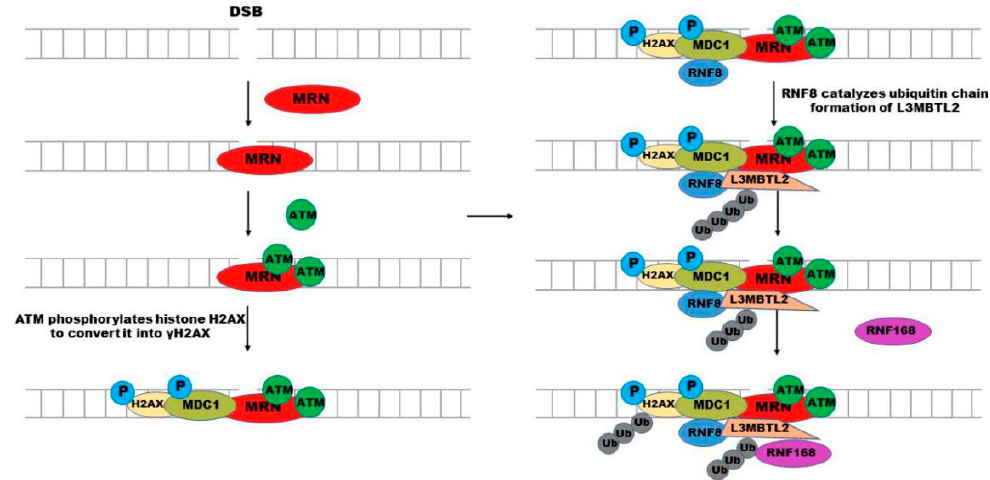
Figure 4. RNF168 participates in the DSB repair process. When the DNA double strand breaks, the MRN complex recognizes the DSB site, and then ATM kinase is recruited to the DSB site by MRN to phosphorylate ser139 of histone H2AX to convert it into γ H2AX. MDC1 can sense γ H2AX accumula- tion at the damage site and is then phosphorylated by ATM. RNF8 recognizes the phosphorylated MDC1 and is recruited to the DSB site. ATM-mediated L3MBTL2 phosphorylation promotes its interaction with MDC1 and recruitment to DSB site. Then, RNF8 catalyzes the formation of L3MBTL2 ubiquitin chain, which can promote the recruitment of RNF168 at DSB site. Then, histone N-terminal lysine (k) 13/15 is ubiquitinated by RNF168.